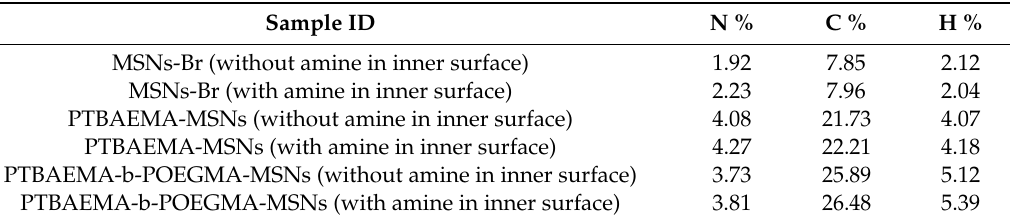
Table 1. Elemental analysis data obtained for the fabricated mesoporous silica nanoparticles.